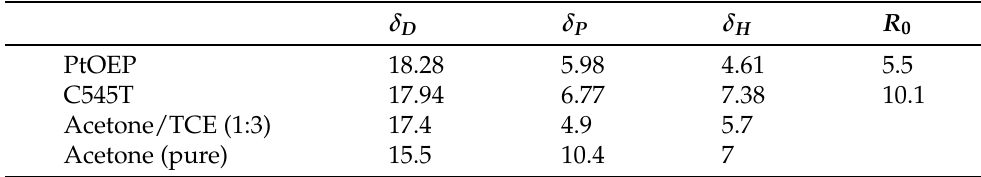
Table 2. HSPs for luminophores and solvent